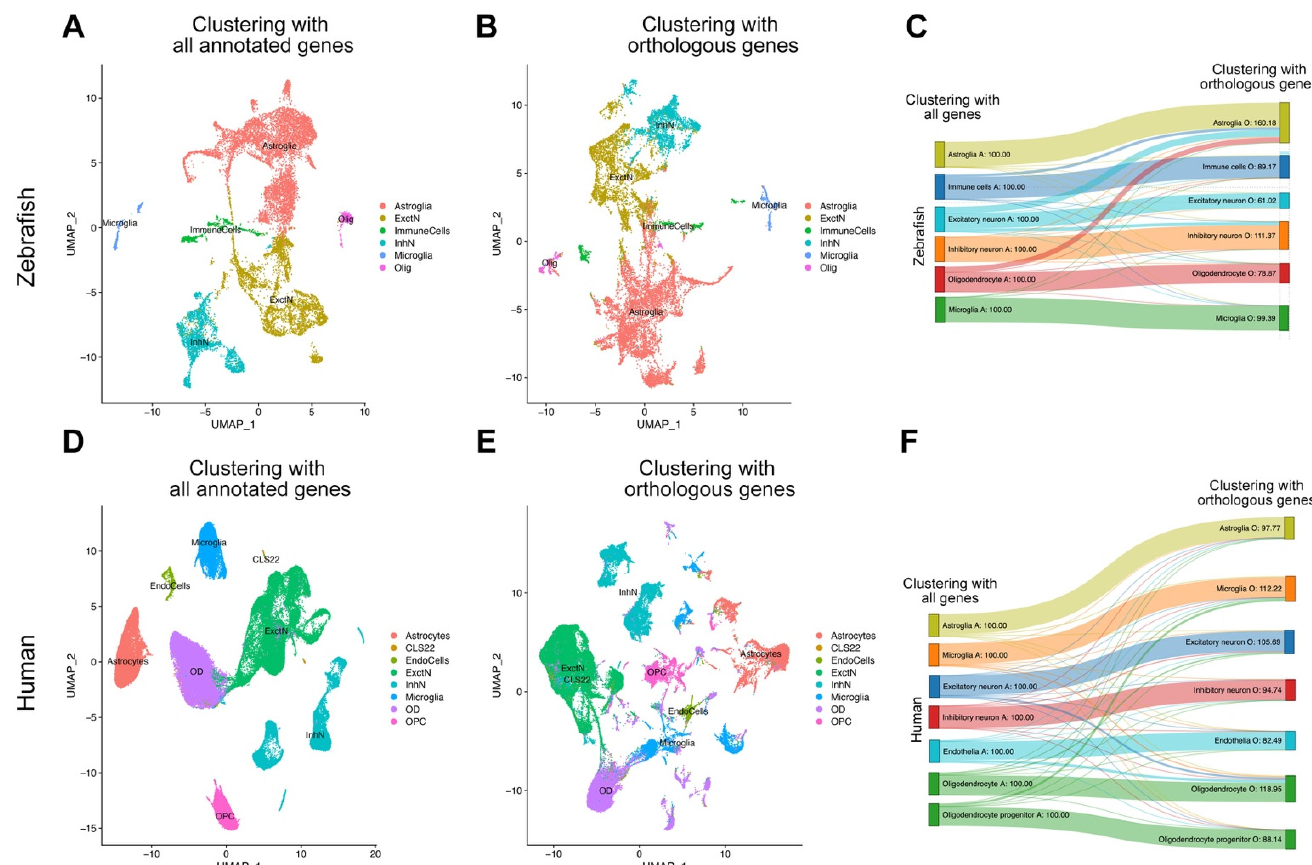
Figure 2. Transition analysis between cell clusters. ( A ) tSNE plot showing the main cell types in zebrafish when all genes annotated in zebrafish are used for clustering. ( B ) tSNE plot showing the main cell types in zebrafish when only the genes orthologous to humans are used for clustering. ( C ) Transition diagram between ( A , B ). When human orthologous genes are used, majority of the cell types remain in their clusters, with slight exception of a subset of oligodendrocytes, excitatory neurons, and inhibitory neurons that start clustering in astroglia. ( D ) tSNE plot showing the main cell types in humans when all genes annotated in humans are used for clustering. ( E ) tSNE plot showing the main cell types in humans when only the genes orthologous to zebrafish are used for clustering. ( F ) Transition diagram between ( D , E ). When zebrafish orthologous genes are used, the vast majority of the cell types remain in their clusters.